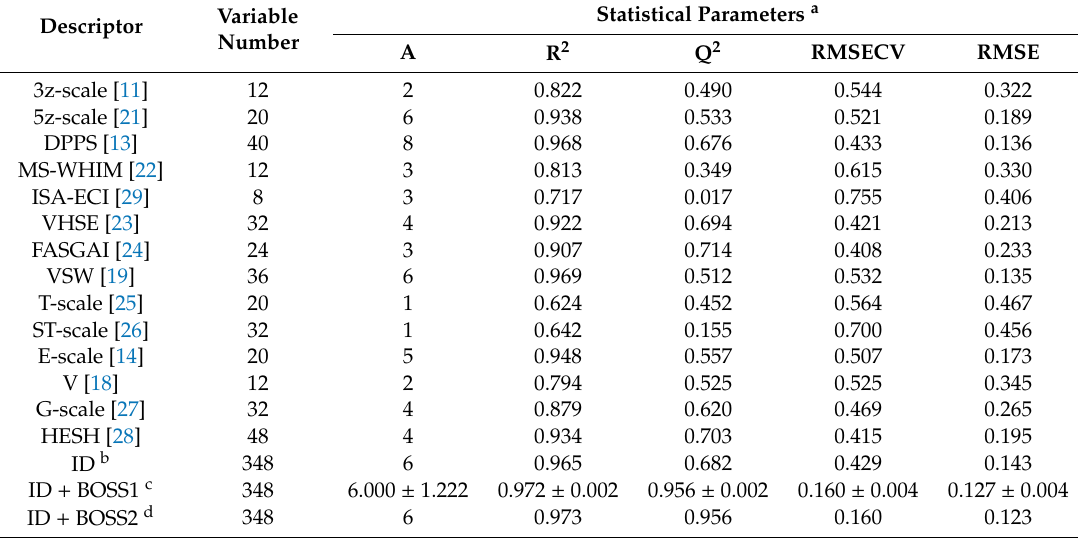
Table 4. Statistical parameters of QSAR models for tetrapeptides using a single set of amino acid descriptor and comparison with models built by integrated descriptor